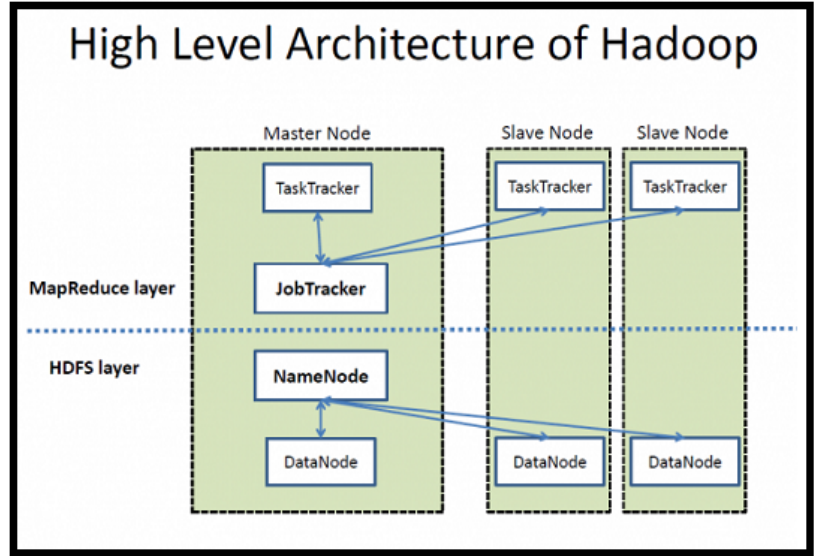
Figure 1. High-Level Architecture of Hadoop.